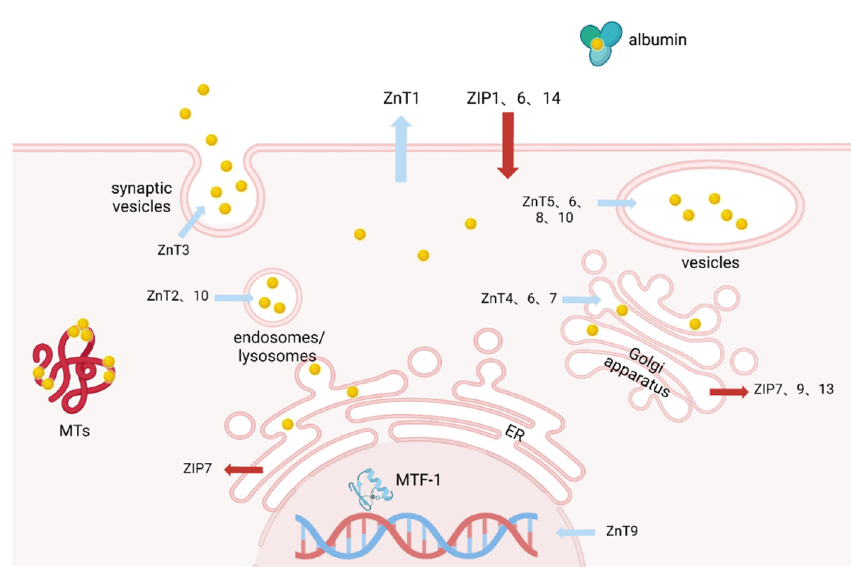
Figure 1. The localization of zinc transporters Zrt-, Irt-like proteins (ZIP, red arrow), Zn transporters (ZnT, blue arrow), metallothioneins (MTs), and metal response element-binding transcription factor-1 (MTF-1) in the cell.